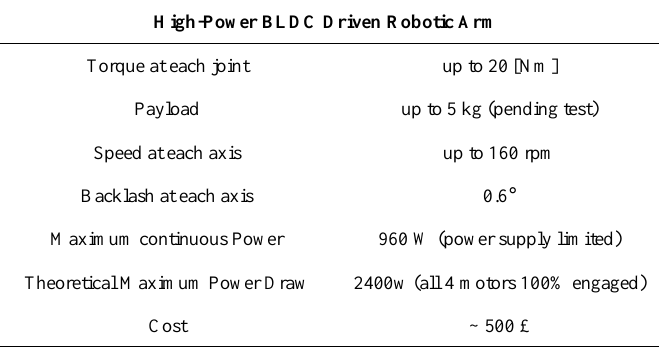
Table 5. Key performance parameters of the arm